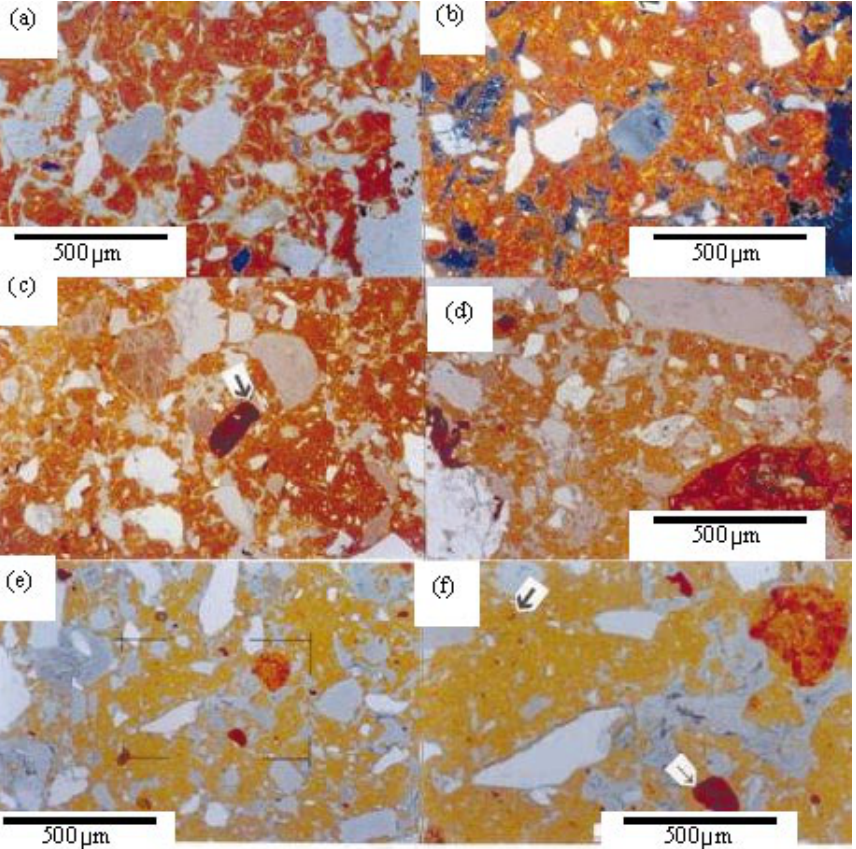
Figura 3. Fotomicrografias de alguns horizontes Bw selecionados 1. Setas indicam feições micropedológicas discutidas no